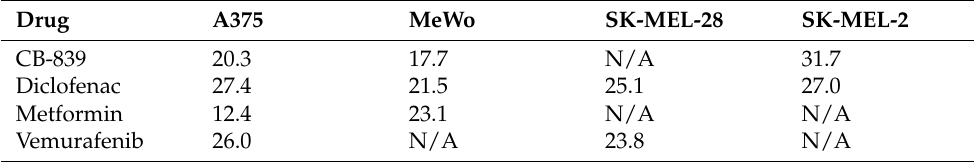
Table 3. Synergy scores of the tested combinations in all cell lines *.